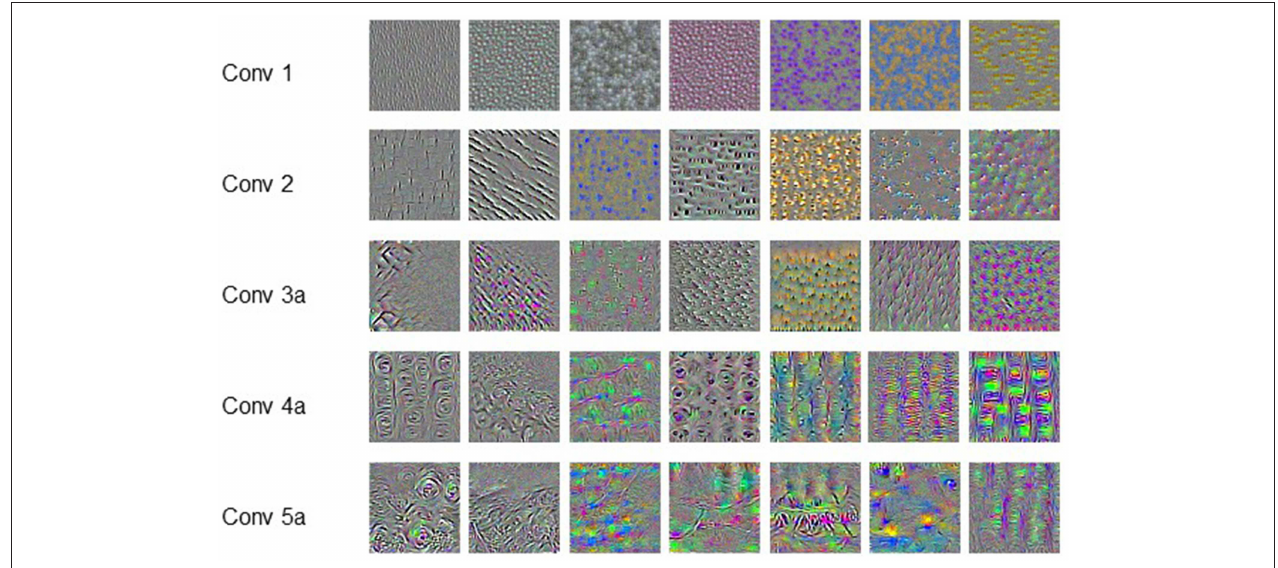
FIGURE 4 | Convolution